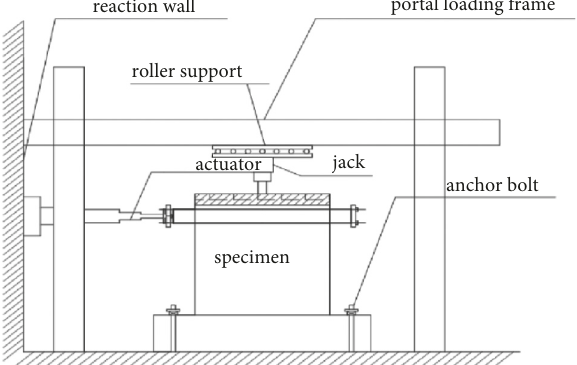
Figure 4: Test setup.